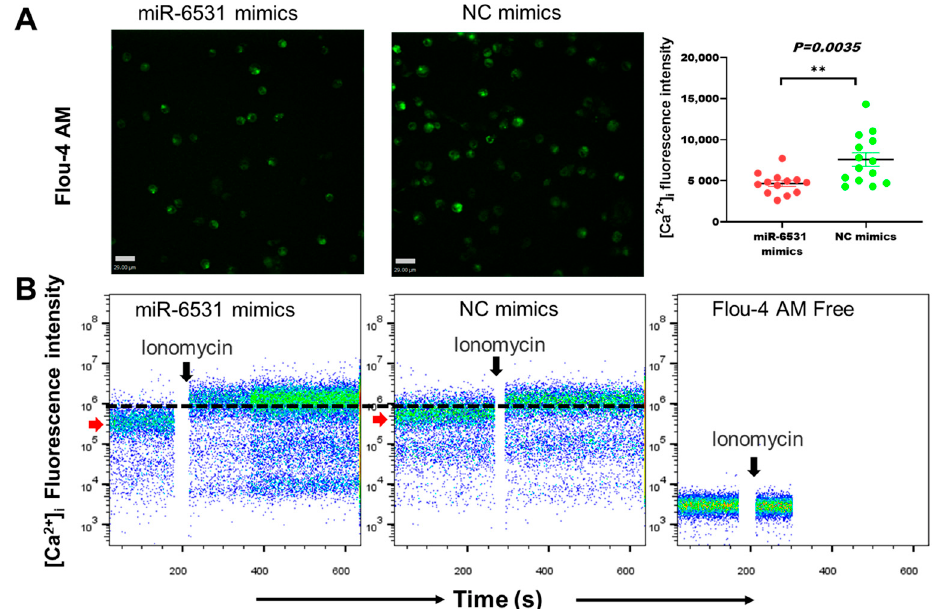
Figure 2. The [Ca 2+ ] i signaling was detected by using Flou-4 AM in bovine Leydig cells after transfecting miR-6531 mimics or NC mimics. ( A ) The [Ca 2+ ] i intensity test by fluorescence microscopy. ( B ) The fluorescence intensity of calcium was detected before or after ionomycin addition by flow cytometry ( ** p < 0.01 ).